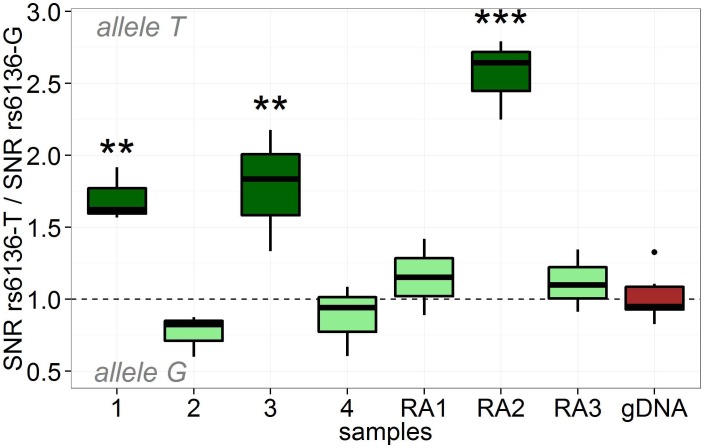
Cis-directed DAE pattern of rs6136 in the SELP gene.Green boxplots indicate samples resulting from allele specific expression analysis of cDNA. Samples tagged “RA” were derived from RA patients, which was not the case for samples 1–4; gDNA = allelic ratios of gDNA samples which served as reference. SNR = signal to noise ratio. Stars indicate cDNA samples with increased expression of transcripts carrying variant rs6136-T. ** = p-val<0.01, *** = p-value<0.001.